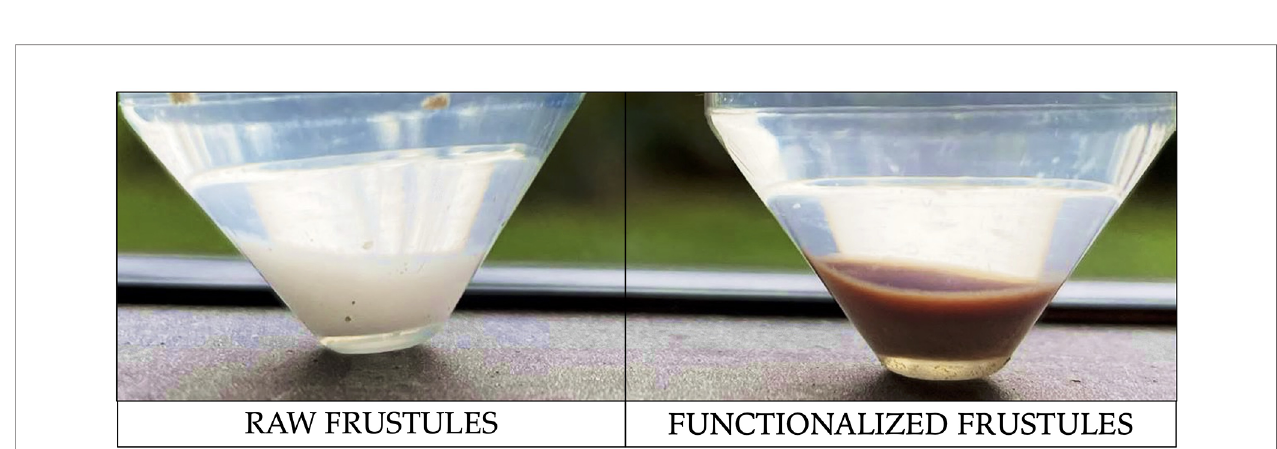
FIGURE 8 | Ni removal ef fi ciency of raw and functionalized frustules as a function of time. Data are reported as averaged values of triplicates ± standard deviation.